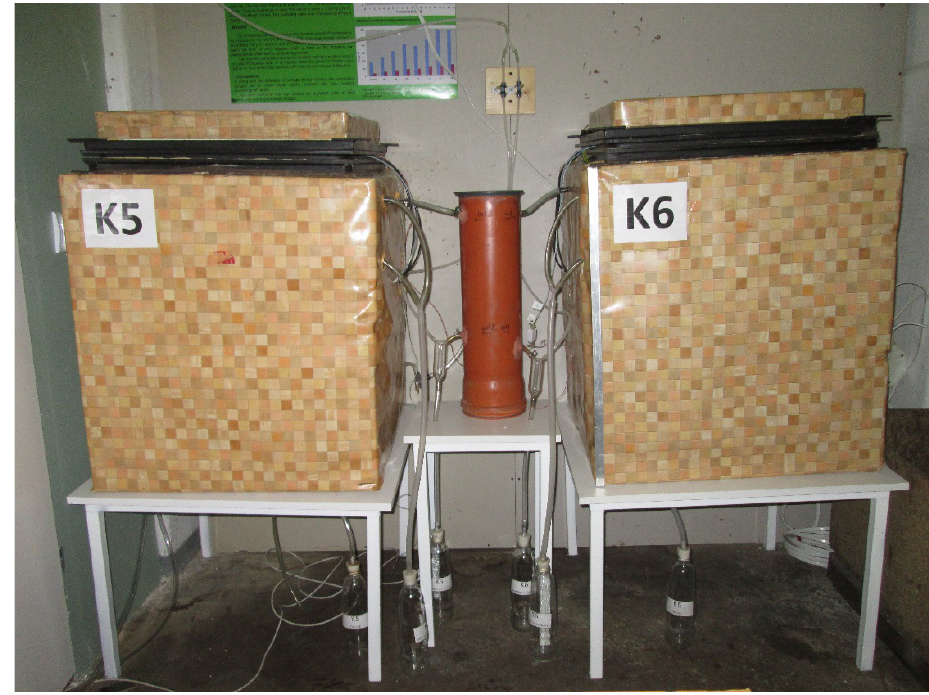
Figure 1. The design of two chambers bioreactor to study the composting process.